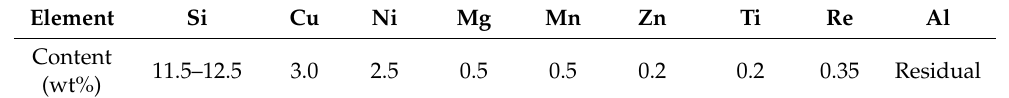
Table 1. The chemical composition of the piston.